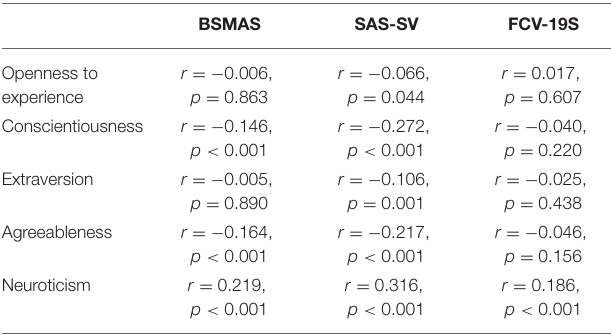
TABLE 1 | Associations between the BFI-44 scales (personality traits in the left column), the BSMAS, the SAS-SV and the FCV-19S. Openness to experience